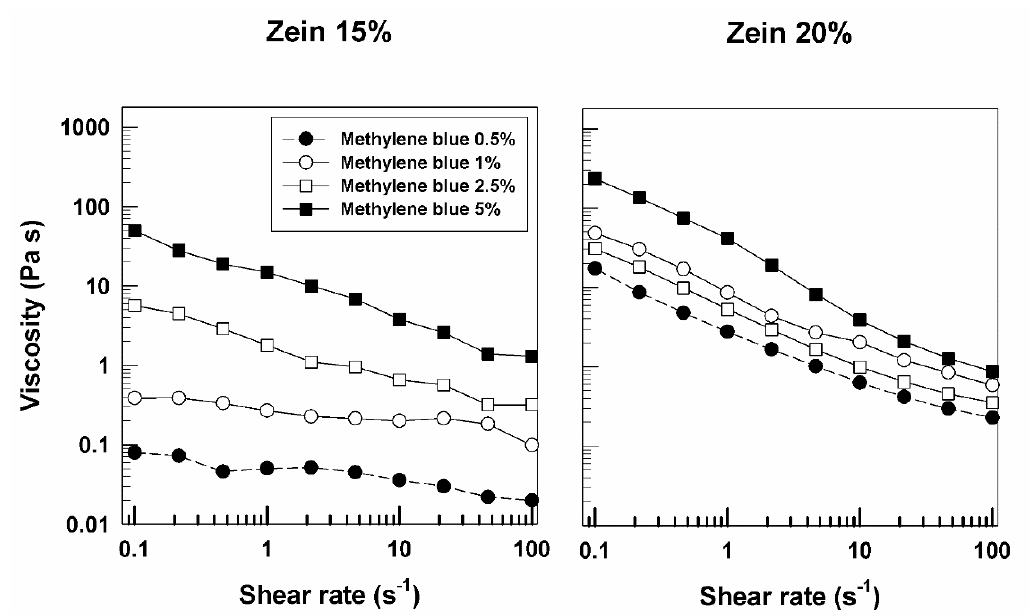
Figure 9. Evaluation of viscosity of zein samples containing methylene blue as a function of the shear rate.